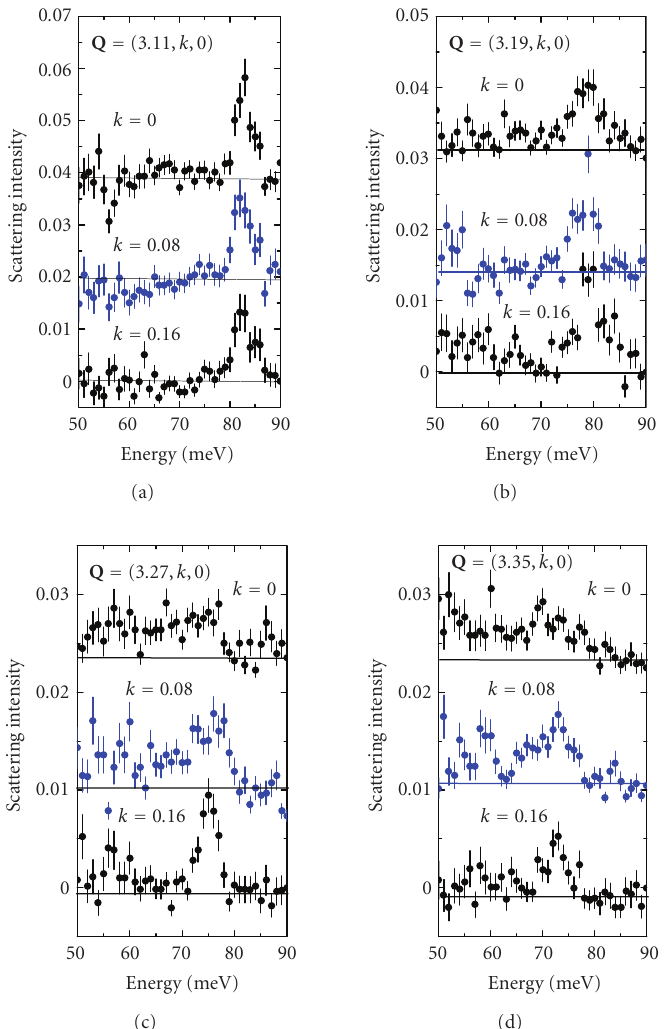
Figure 12: IXS energy scans after subtraction of the elastic tail and a constant term corresponding to the stray radiation. The scans were taken with q = ( h, k , 0) with h = 0.11, 0.19, 0.27, 0.35 (from the left to the right column) and k as indicated in the figure. The most interesting features are the suppression of the two-component behavior seen by INS at 77meV near Q = (3.27, 0, 0) and the rapid narrowing and hardening of the phonon line from k = 0 to k = 0.16 for Q = (3.27, k , 0). From